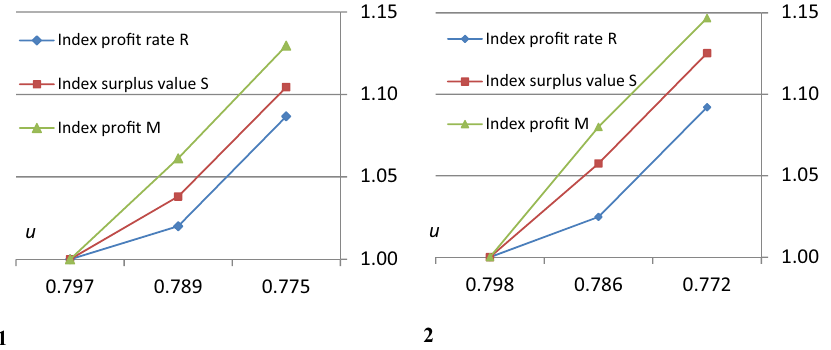
Fig. 13 Effects of separate and combined changes in targeted capital-output ratio s b and capital accumulation rate z b on relative wage u , profit rate R , surplus value S and profit M averaged over years 0–250 (panel 1) and 230–250 (panel 2) against run 1 with